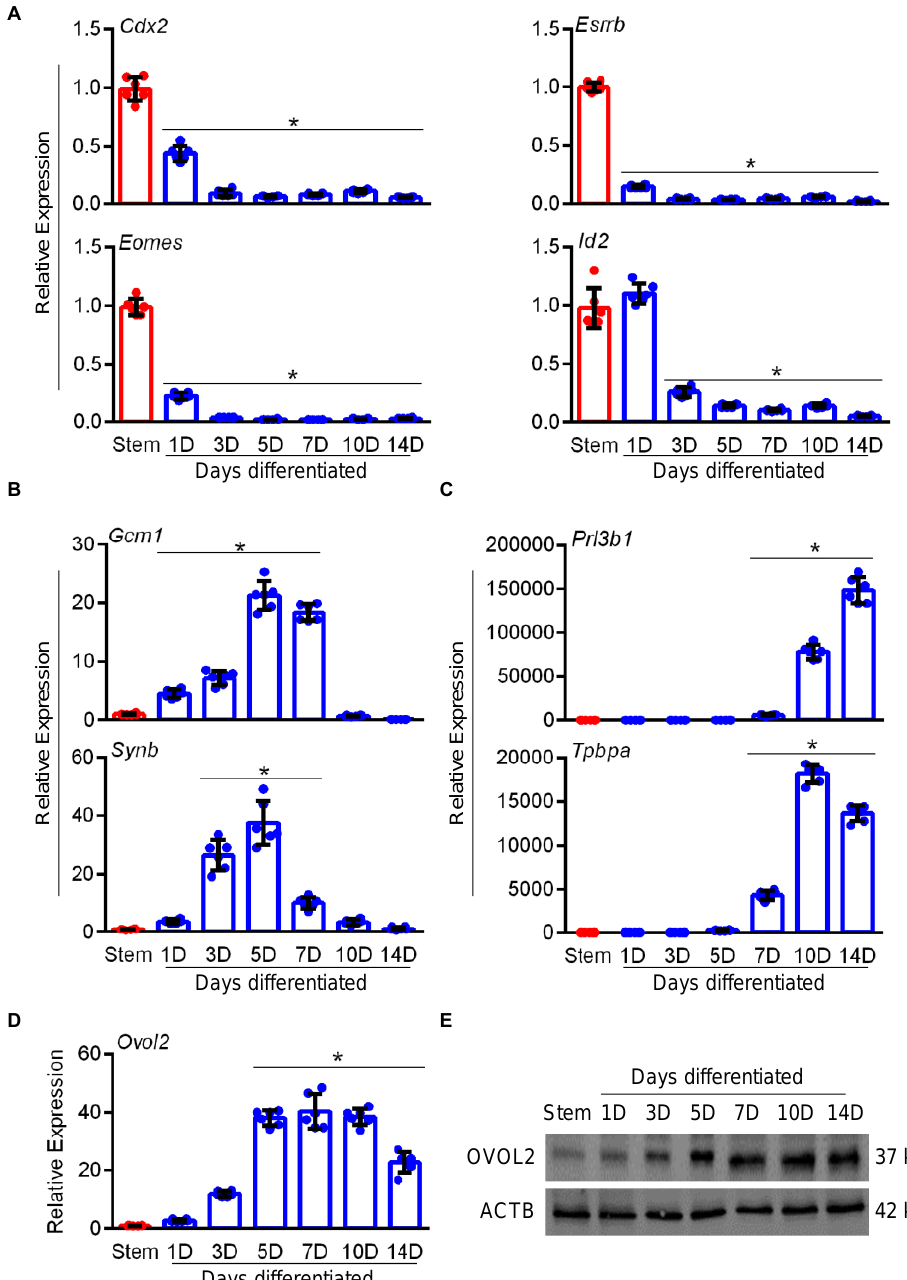
Figure 3. Increased expression of OVOL2 during mouse TS cell di ff erentiation. Quantitative RT-PCR analysis of ( A ) stem ( Cdx2, Eomes , Esrrb , and Id2 ) and di ff erentiation markers for the ( B ) labyrinth zone ( Gcm1 , Synb ) and ( C ) junctional zone ( Prl3b1 and Tpbpa ) in mouse TS cells cultured under stem or di ff erentiation conditions for up to 14 days. ( D ) Quantitative RT-PCR and ( E ) and Western blot analysis of OVOL2 expression in mouse TS cells cultured under stem or di ff erentiation conditions for up to 14 days. ACTB was used as a loading control for Western blots. Values significantly di ff erent from stem conditions (N = 6, P < 0.05) are indicated with an asterisk (*). Graphs represent means